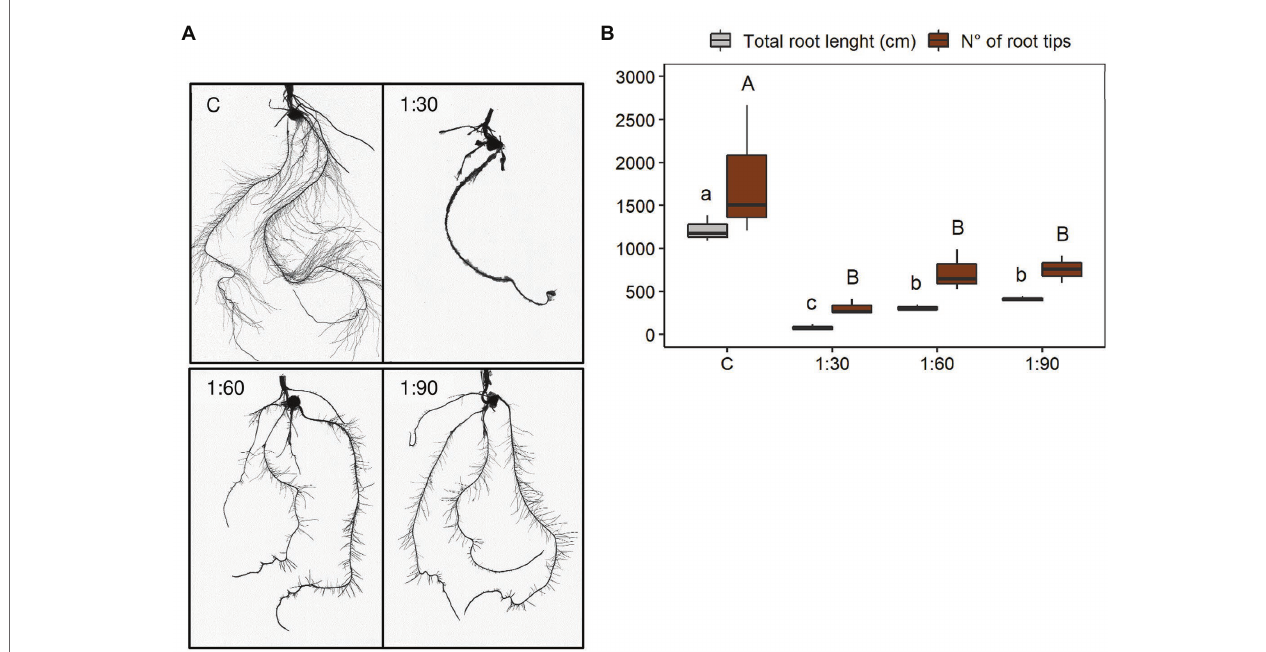
FIGURE 4 | Morphological parameters of root systems of 15-day-old maize seedlings grown in the full-strength nutrient solution (C, control) and in the AHL diluted with distilled water in a ratio of 1:30, 1:60, and 1:90 (v/v): (A) WinRHIZO images and (B) total root length and number of root tips. Data are presented as means ± SE ( n = 12). Statistical significance was tested by one-way ANOVA analysis with LSD post-test (p < 0.05). Statistically significant differences among the four different growth conditions are indicated by different letters: different lower case letters indicate significant differences among the growth conditions in total root length; different upper case letters indicate significant differences among the growth conditions in a number of root